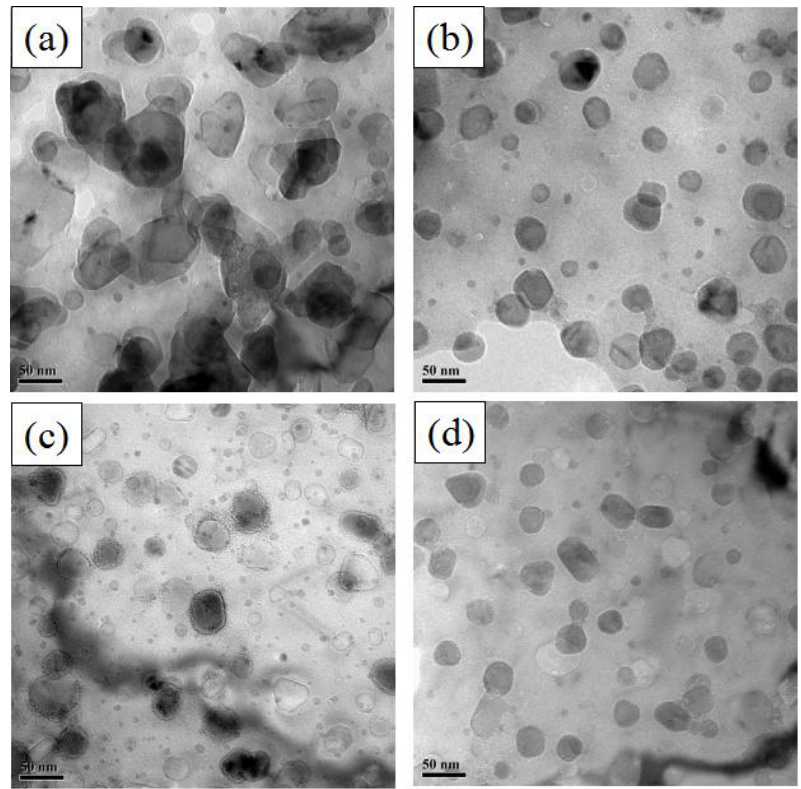
Figure 4. Dispersed nano-sized second phases in the matrix of FeCrAl ODS steels with different Zr